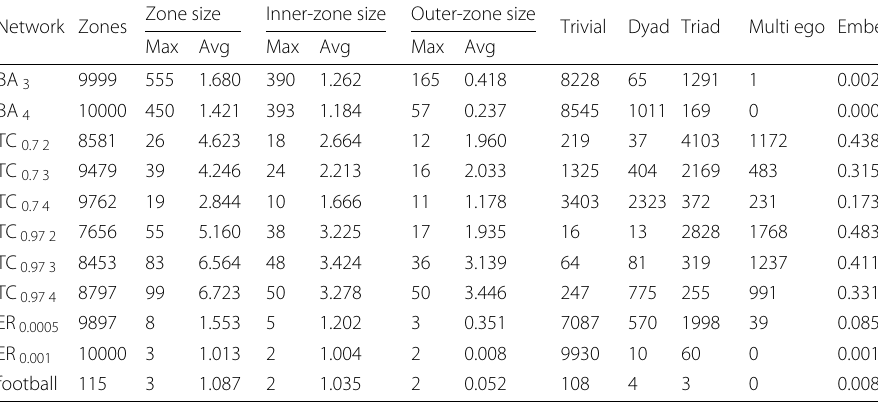
Table 8 Zone properties in generated networks Zone Network Zones